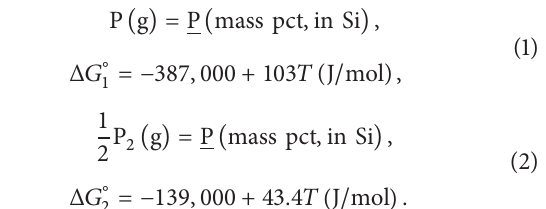
Table 1: Acceptable contents of impurity in SoG-Si ( C Element Fe Al Cu Ti Ca C O P B Acceptable content, C SoG-Si (ppmw)